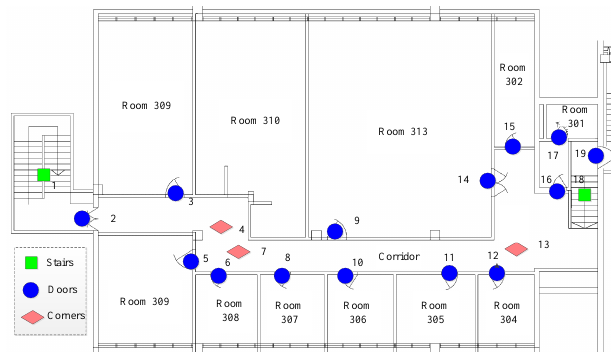
Figure 3: Landmarks derived from maps